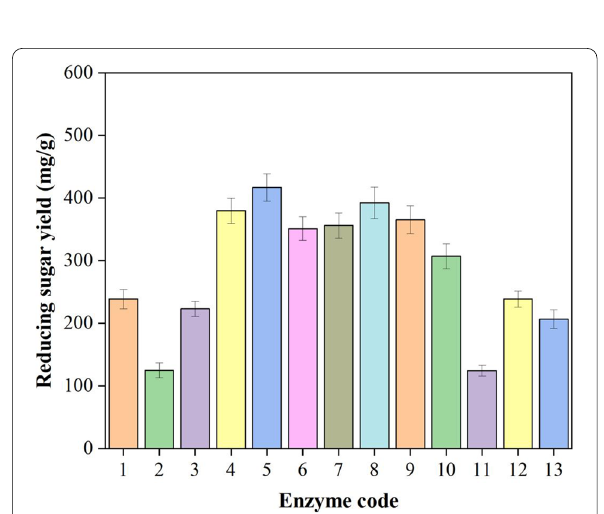
Fig. 6 Enzymatic hydrolysis of pretreated ramie stalks by different cellulase consortiums (The number of the horizontal coordinates corresponding to enzyme code of Table